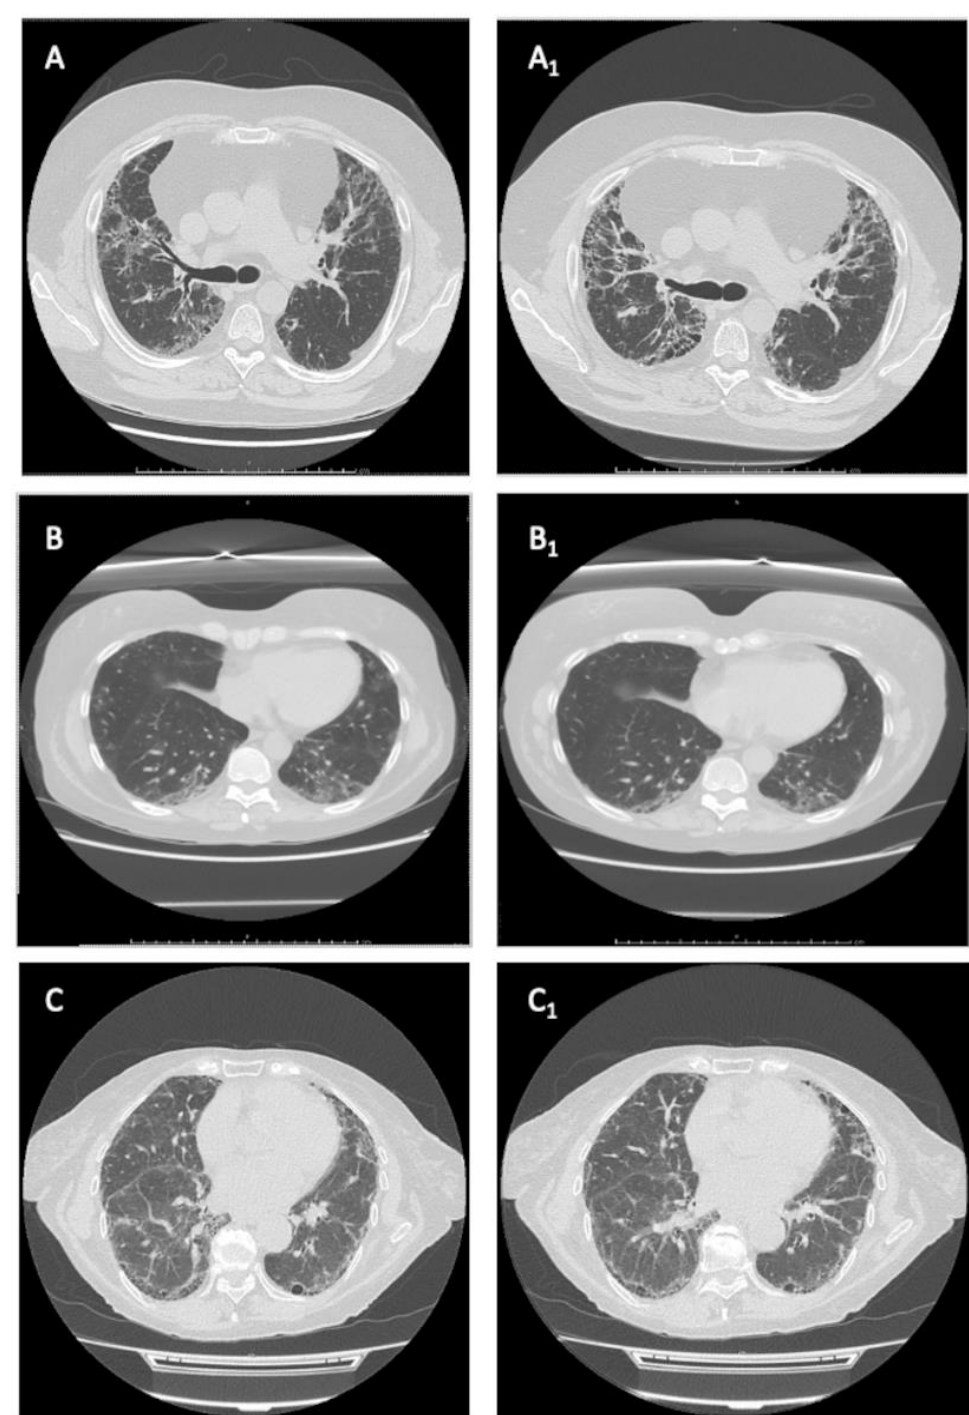
Figure 3. Representative HRCTs. ( A , A 1 ) series: a “worsened” RA-ILD with UPI pattern in a patient treated with baricitinib. ( B , B 1 ) series: an “improved” RA-ILD with indeterminate pattern in a patient treated with baricitinib. ( C , C 1 ) series: a “stable” RA-ILD with UIP pattern in a patient treated with baricitinib.